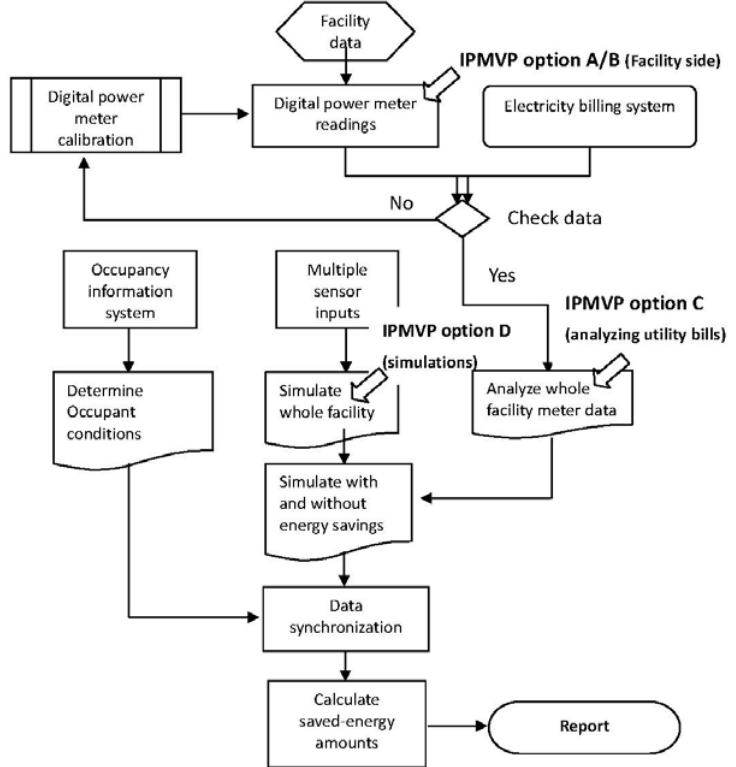
Figure 3. Algorithm for the sensor platform to determine the amount of energy